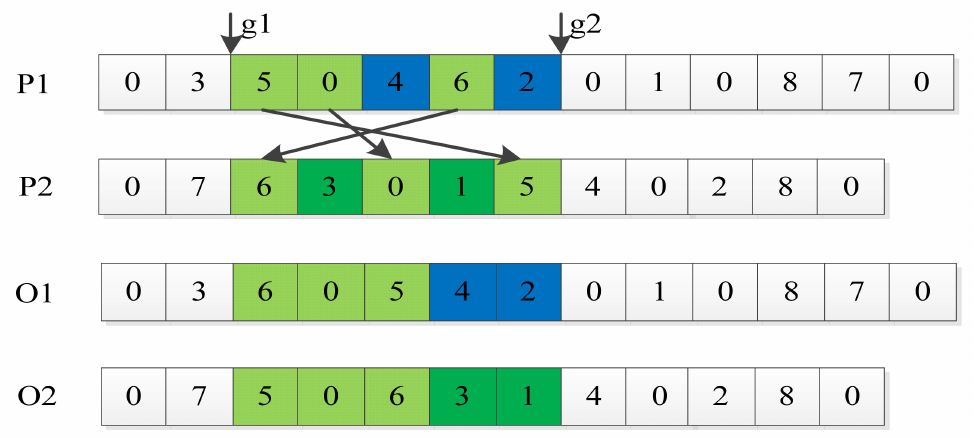
Figure 2. 2-point crossover operation.